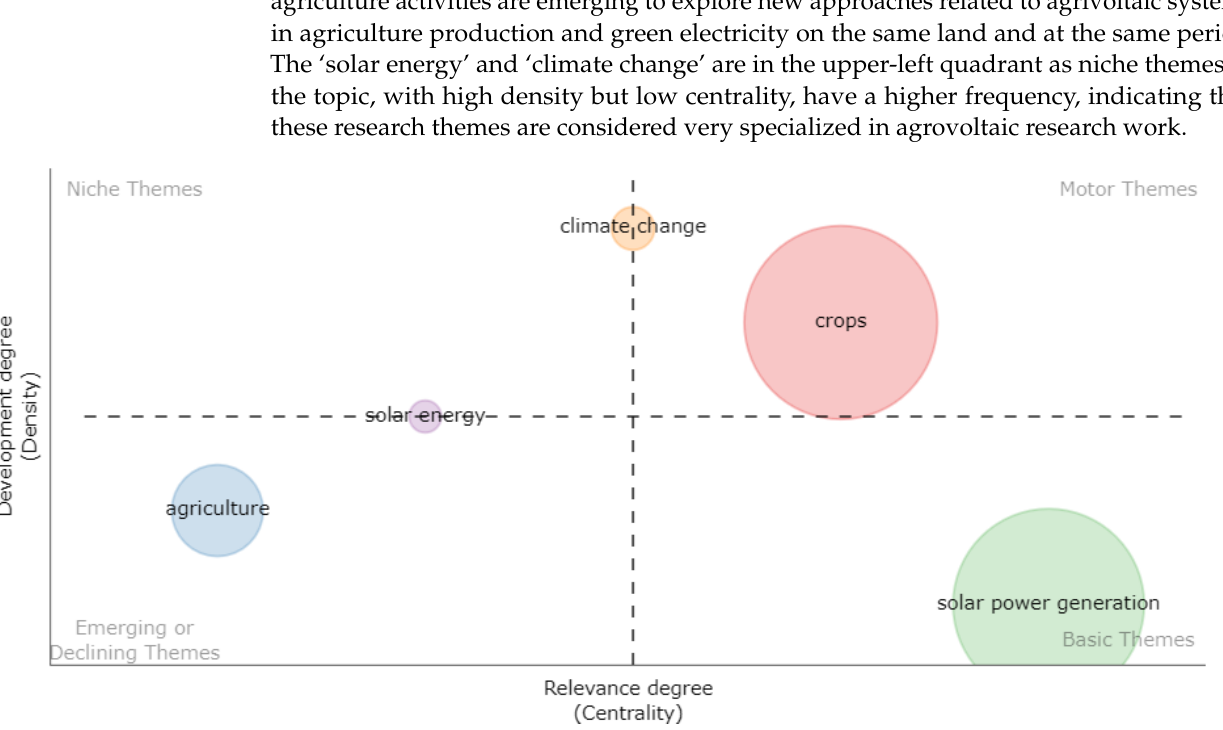
Figure 6. Thematic map. Source: created by the authors.